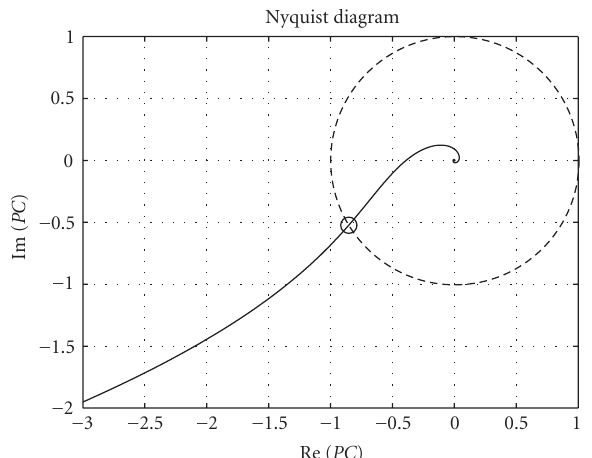
Figure 2: Nyquist plot of the open loop transfer function PC .